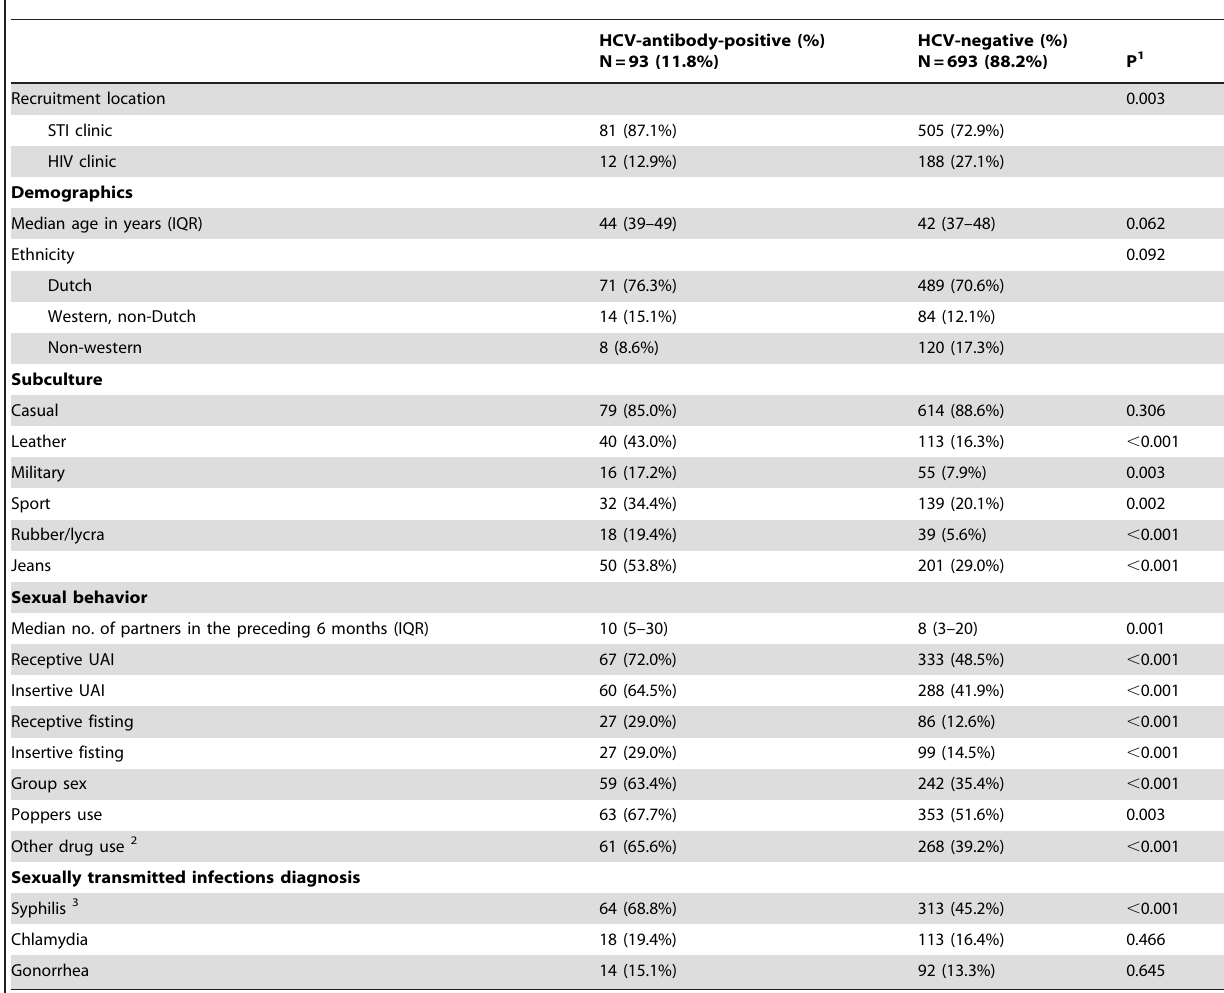
Table 2. Characteristics of 786 HIV-infected men who have sex with men, by hepatitis C antibody status, who visited the STI outpatient clinic of the Public Health Service or the HIV outpatient clinic of the Academic Medical Center in Amsterdam, 2008–